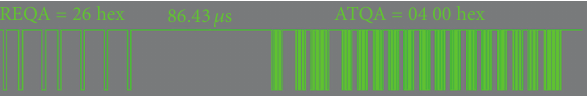
Figure 1: Signal received on the tower.